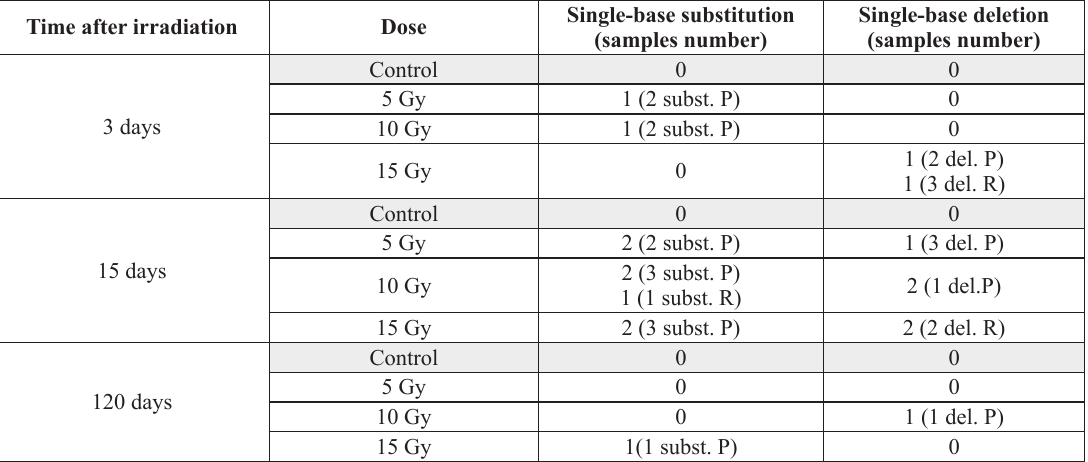
Single-base substitution (samples number)